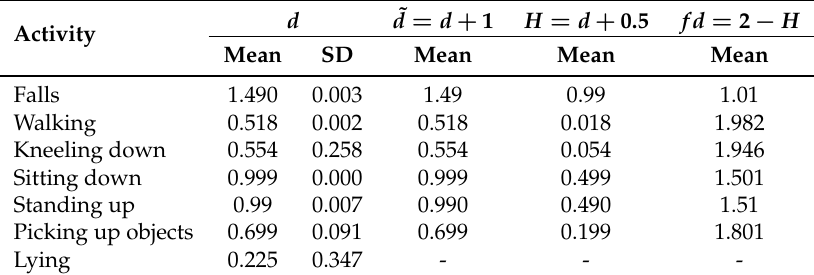
Table 2. Hurst exponent from ARFIMA